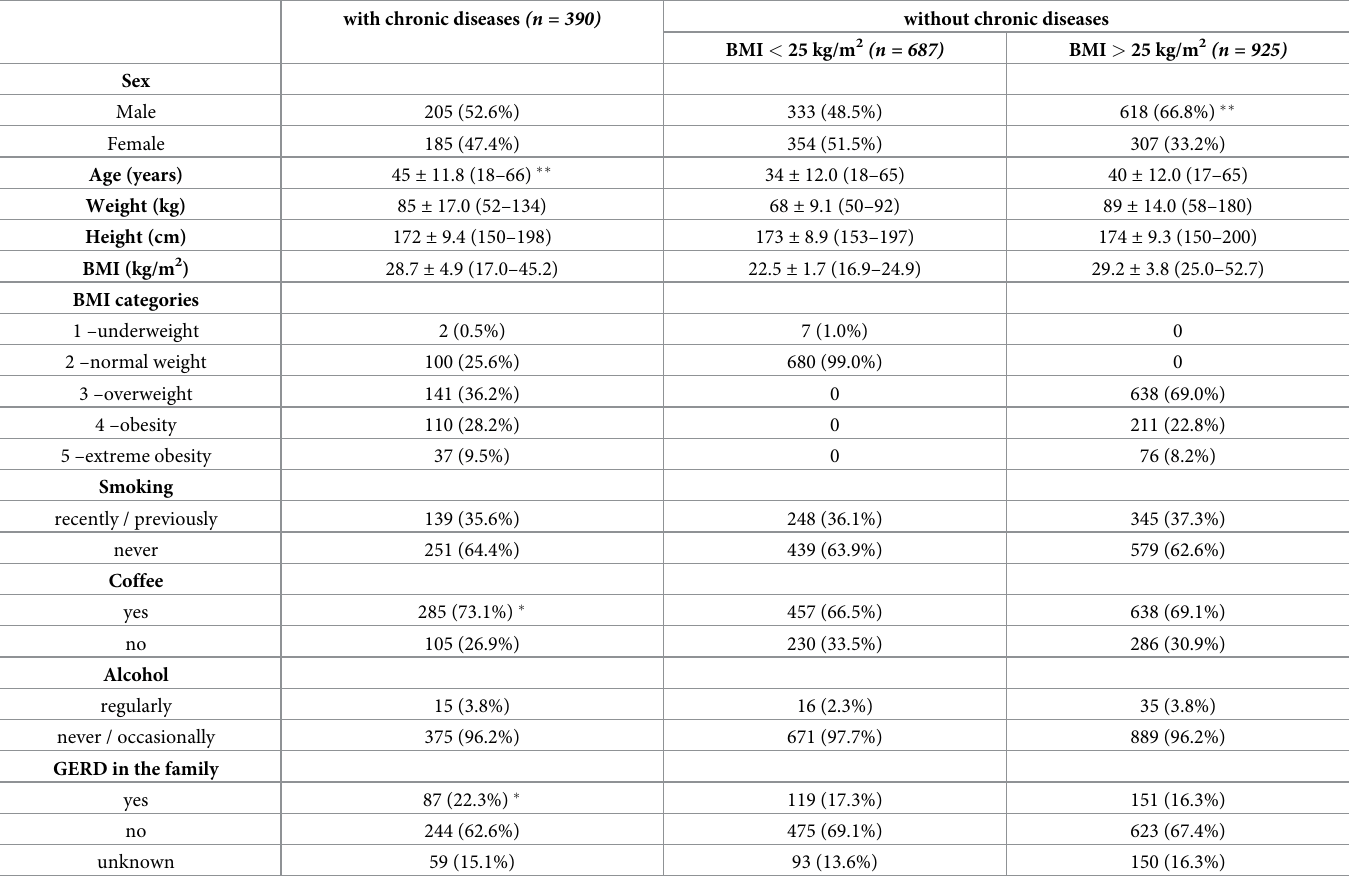
Table 6. Socioeconomical factors of blood donor volunteers according to the presence of coexisting, chronic diseases. Age, weight, height, and BMI are presented with mean ± SD and range. with chronic diseases (n =